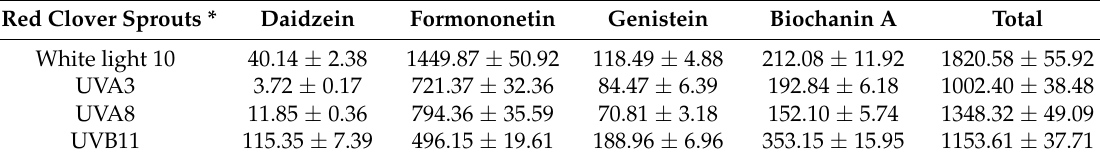
Table 1. Concentration (mg/100 g d.b.) of isoflavones in red clover